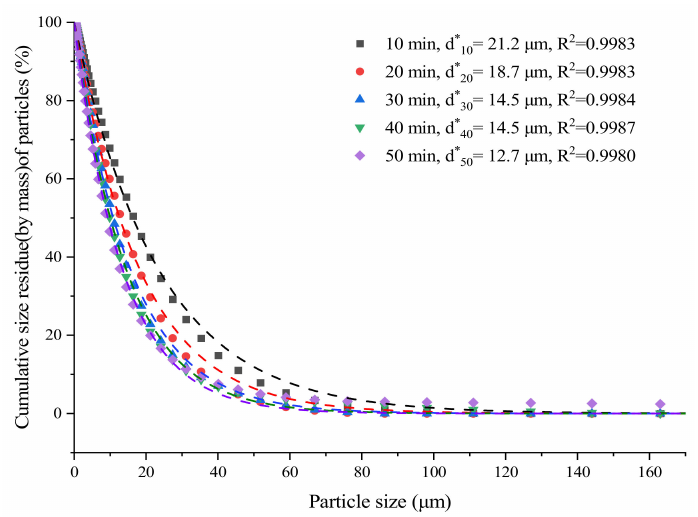
Figure 8. RRB function fitting of LVTC powder grinding for different times.